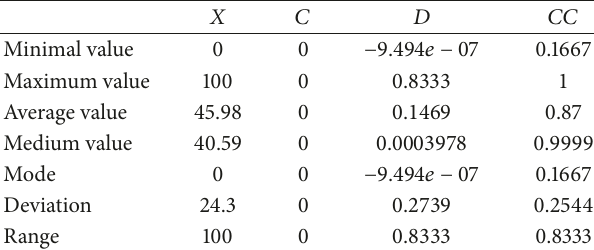
Table 9: The statistical analyses of strategies 𝐶 , 𝐷 , and 𝐶𝐶 .